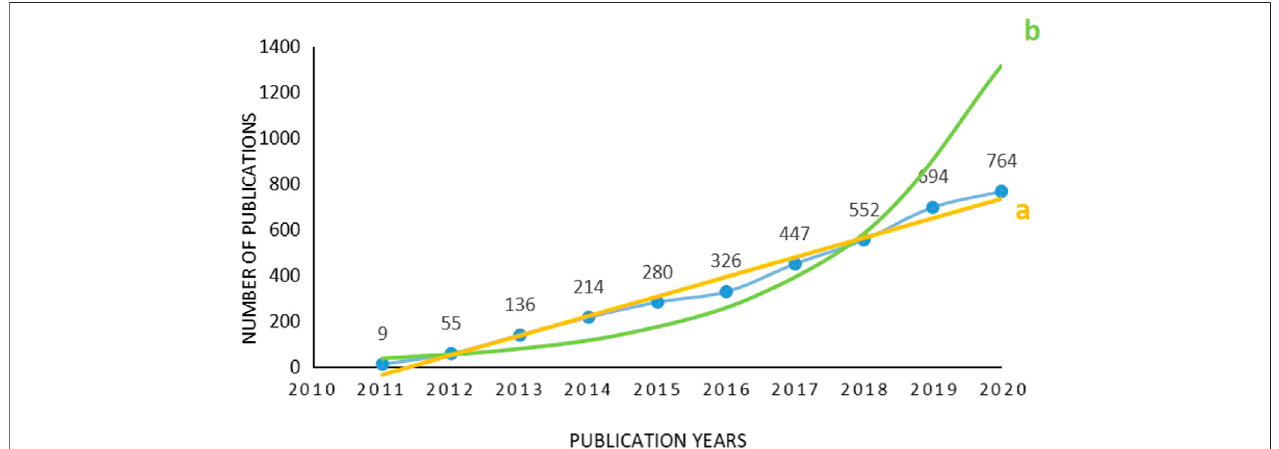
FIGURE2 | Distributionof publications on SMAD7 inthe fi eld ofoncology according tothe year. Footnote: The number ofpublications increased gradually year by year from 2011 to 2020, and the number of publications rose relatively sharply from 2016 to 2019, then reached a peak in 2020. Linear adjustment (a): y = 85.412x- 171800, r 2 = 0.9819. Exponential adjustment (b): y = 22.512e 0.4066x , r 2 = 0.8125.